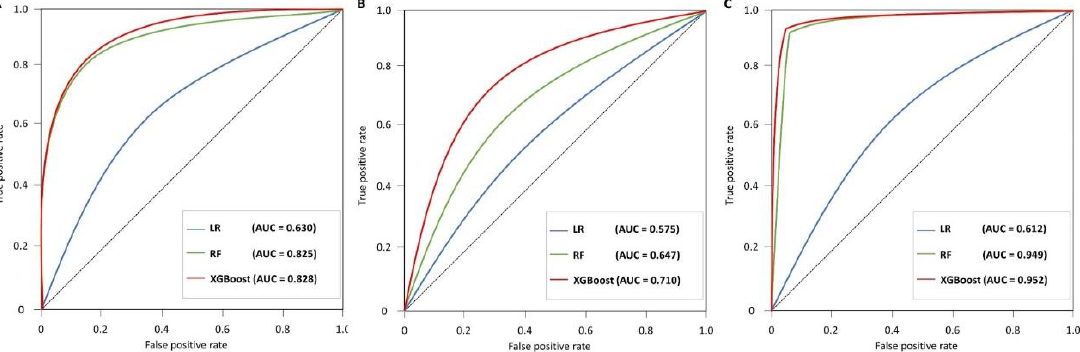
Figure 4. Comparison of receiver operating characteristics curves for ( A ) hypertension, ( B ) diabetes mellitus, and ( C ) hypertension and diabetes mellitus.